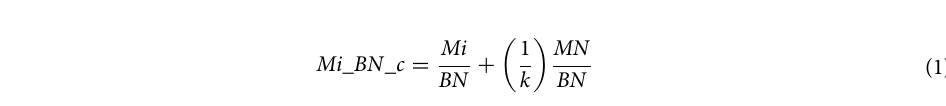
Figure 1. Schematic representation of the experimental design for this study. Details are explained in the main